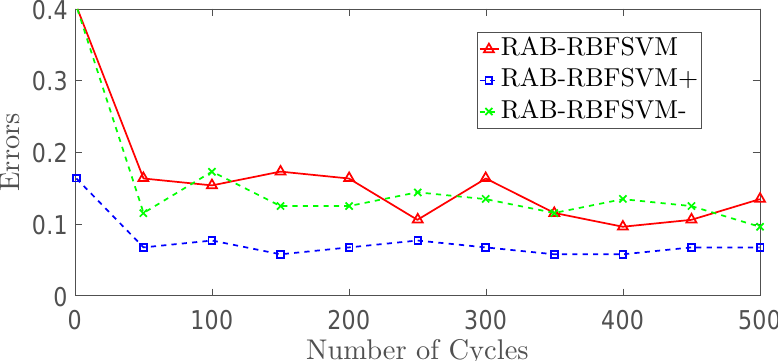
Figure 11. Performances of RAB-RBFSVM and Performances of RAB-RBFSVM, RAB-RBFSVM − and